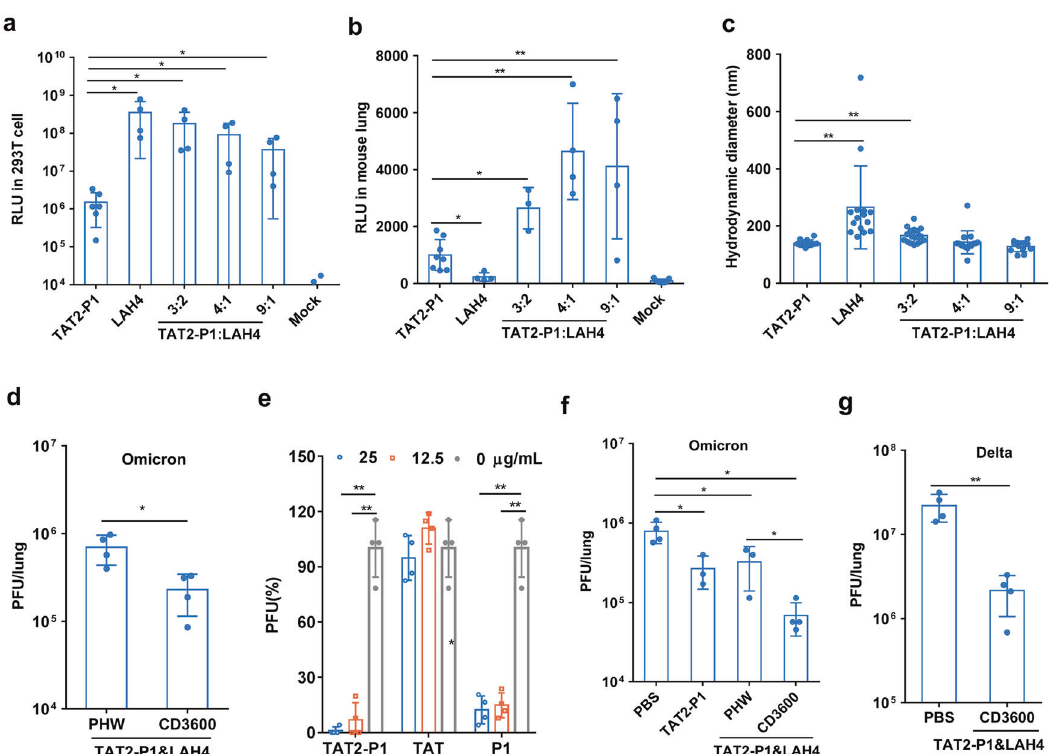
Fig. 5 TAT2-P1&LAH4 enhanced the gene expression and inhibited SARS-CoV-2 variants in vivo. a The luciferase expression in 293 T cells. The pCMV-Luc was packaged by the indicated vectors (TAT2-P1, LAH4, and TAT2-P1:LAH4 = 3: 2, 4:1 or 9:1) and was transfected into 293 T cells ( n = 4). b The luciferase expression in mouse lungs ( n = 4). The pCMV-Luc was packaged by the indicated vectors and was inoculated to mouse lungs. The expression of luciferase in mouse lungs was detected at 24 h post transfection. c Peptidic nanoparticle sizes of plasmids packaged by the indicated vectors ( n = 4). * indicates P < 0.05 and ** indicates P < 0.01. d TAT2-P1&LAH4 could deliver CD3600 to signi fi cantly inhibit Omicron ( n = 3) variant replication in hamster lungs. One dose of CD3600 was intratracheally inoculated to hamster lungs at 1-day before viral challenge. Viral loads in hamster lungs were measured at 2-day post infection. e TAT2-P1 signi fi cantly inhibit SARS-CoV-2 infection ( n = 4) in VeroE6 cells. SARS-CoV-2 treated by indicated peptides for plaque reduction assay. PFU (%) was the plaque number of peptide-treated virus normalized to the plaque number of untreated virus. ** indicates P < 0.01. f Two doses of PBS ( n = 4), TAT2-P1 ( n = 3), TAT2-P1&LAH4 with CD3600 ( n = 4) or PHW ( n = 3) were given to hamster lungs at 1-day before and 8 h after Omicron SARS-CoV-2 infection. g PBS ( n = 4) or TAT2-P1&LAH4 with CD3600 ( n = 4) were given to hamster lungs at 1-day before and 8 h after Delta SARS-CoV-2 infection. Viral loads were measured at 2-day post infection. * indicates P < 0.05 and ** indicates P < 0.01 . P values were calculated by the two - tailed Student ’ s t